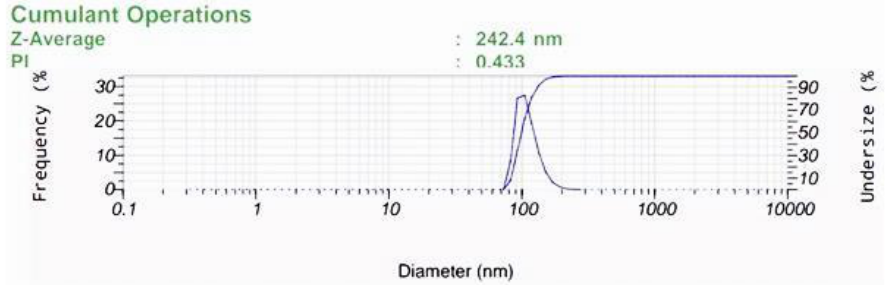
Fig. 3: The best particle size distribution of the nano-gel/emulsion coating